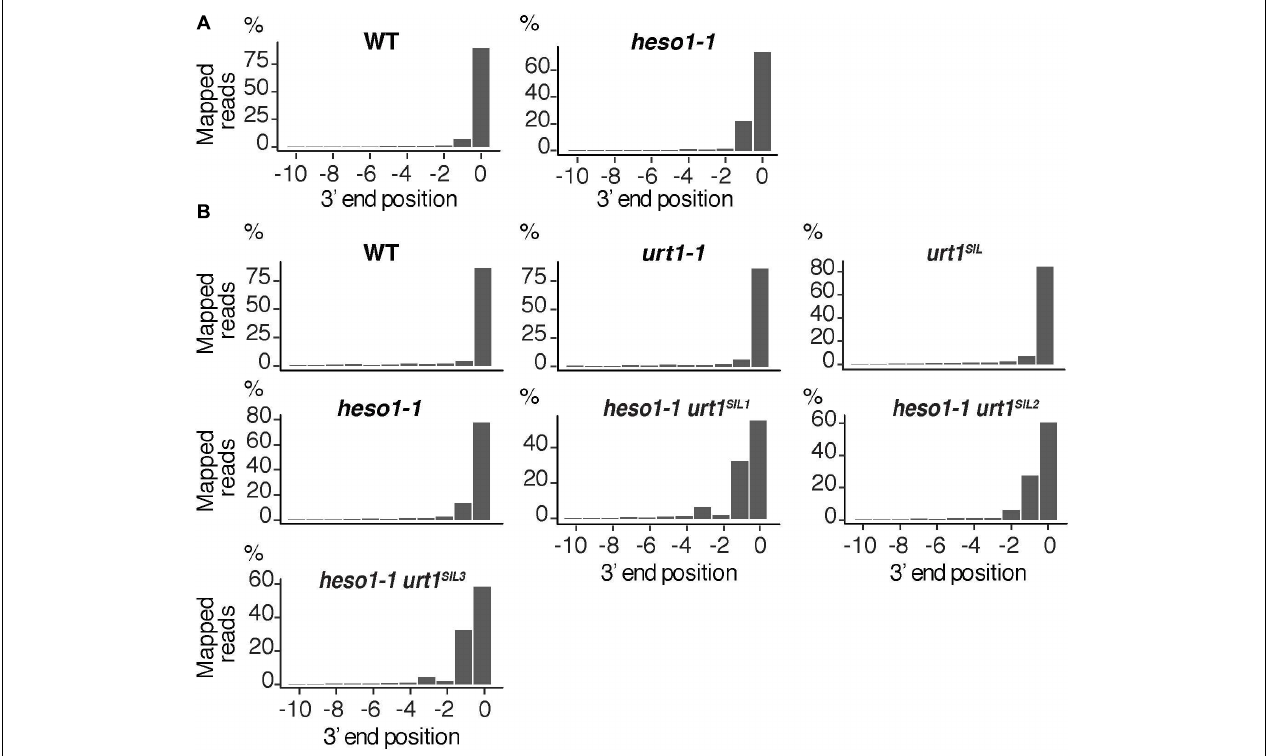
FIGURE 8 | Nibbled SPL13 RISC 5 (cid:48) -cleavage fragments accumulate in the absence of uridylation. Positions of 3 (cid:48) extremities of SPL13 RISC 5 (cid:48) -cleavage fragments mapped in a –10/0 window for (A) four biological replicates, WT and heso1-1 , or (B) two biological replicates for WT, urt1-1 , the urt1 SIL line, heso1-1 , and the three heso1-1 urt1 SIL lines. Graphs are shown separately for each of the replicates in Supplementary Figures S5 , S6 .